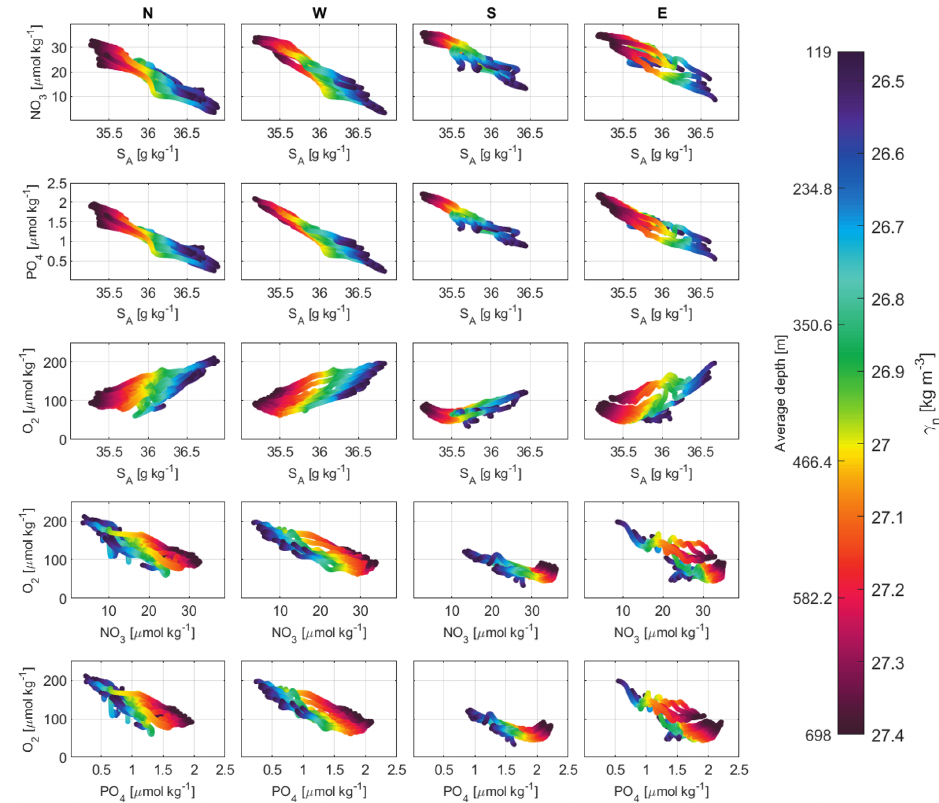
Figure 8. Scatterplots of in situ observations of NO 3 (first row), PO 4 (second row) and O 2 (third row) (in µmolkg − 1 ) with respect to S A and γ n (in color with an approximate scale of the average depths) in the north (N, first column), west (W, second column), south (S, third column) and east (E, fourth column) transects for CW layers. In the fourth and fifth rows, scatterplots of NO 3 –O 2 and PO 4 –O 2 in four transects for the CW layers are